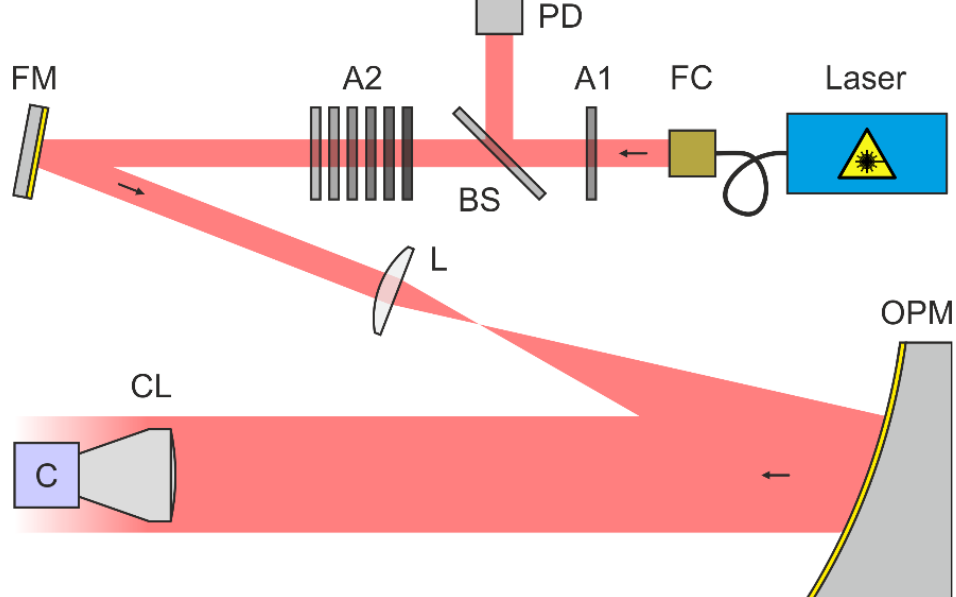
Figure 3. Scheme of the experimental setup for the measurement of the irradiance distribution in the focal plane of camera lenses. FC: fiber collimator, A1/A2: attenuator, BS: beam splitter, PD: reference photodiode, FM: folding mirror, L: focusing lens, OPM: off-axis parabolic mirror, CL: camera lens, C: camera. Taken from reference [22].